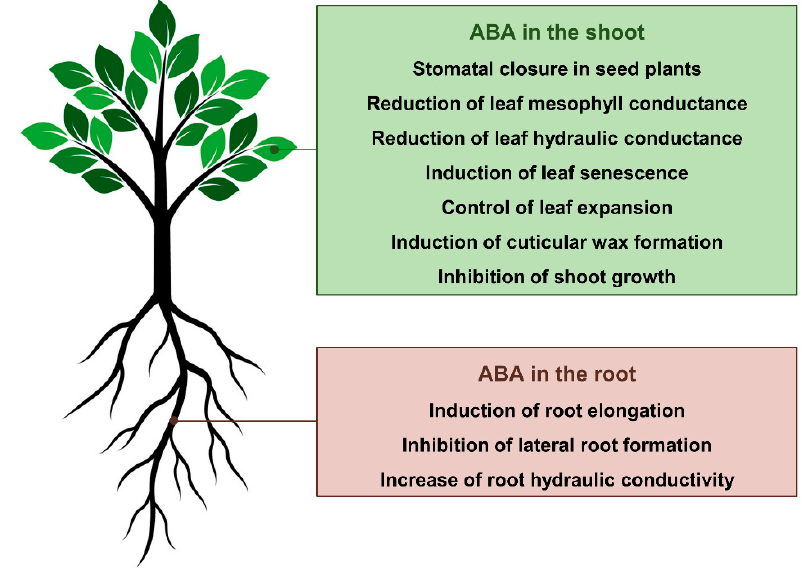
Figure 1. Current understanding of how abscisic acid (ABA) regulates plant form and function during drought.